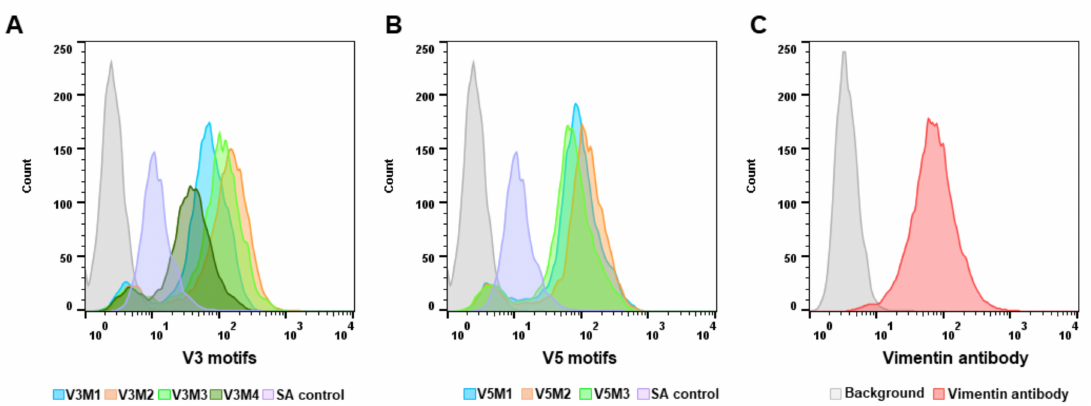
Figure 2. Screening of synthesized aptamer motifs. Synthesized biotinylated motifs of V3 and V5 were incubated with IGROV cells. Fluorescein isothiocyanate (FITC) conjugated streptavidin is used to detect biotinylated motifs. The binding affinity of the aptamer motifs was assessed based on the fluorescence intensity using flow cytometry. Histogram graphs demonstrated the fluorescence intensity of V3 aptamer motifs ( A ), and V5 aptamer motifs ( B ) binding to IGROV